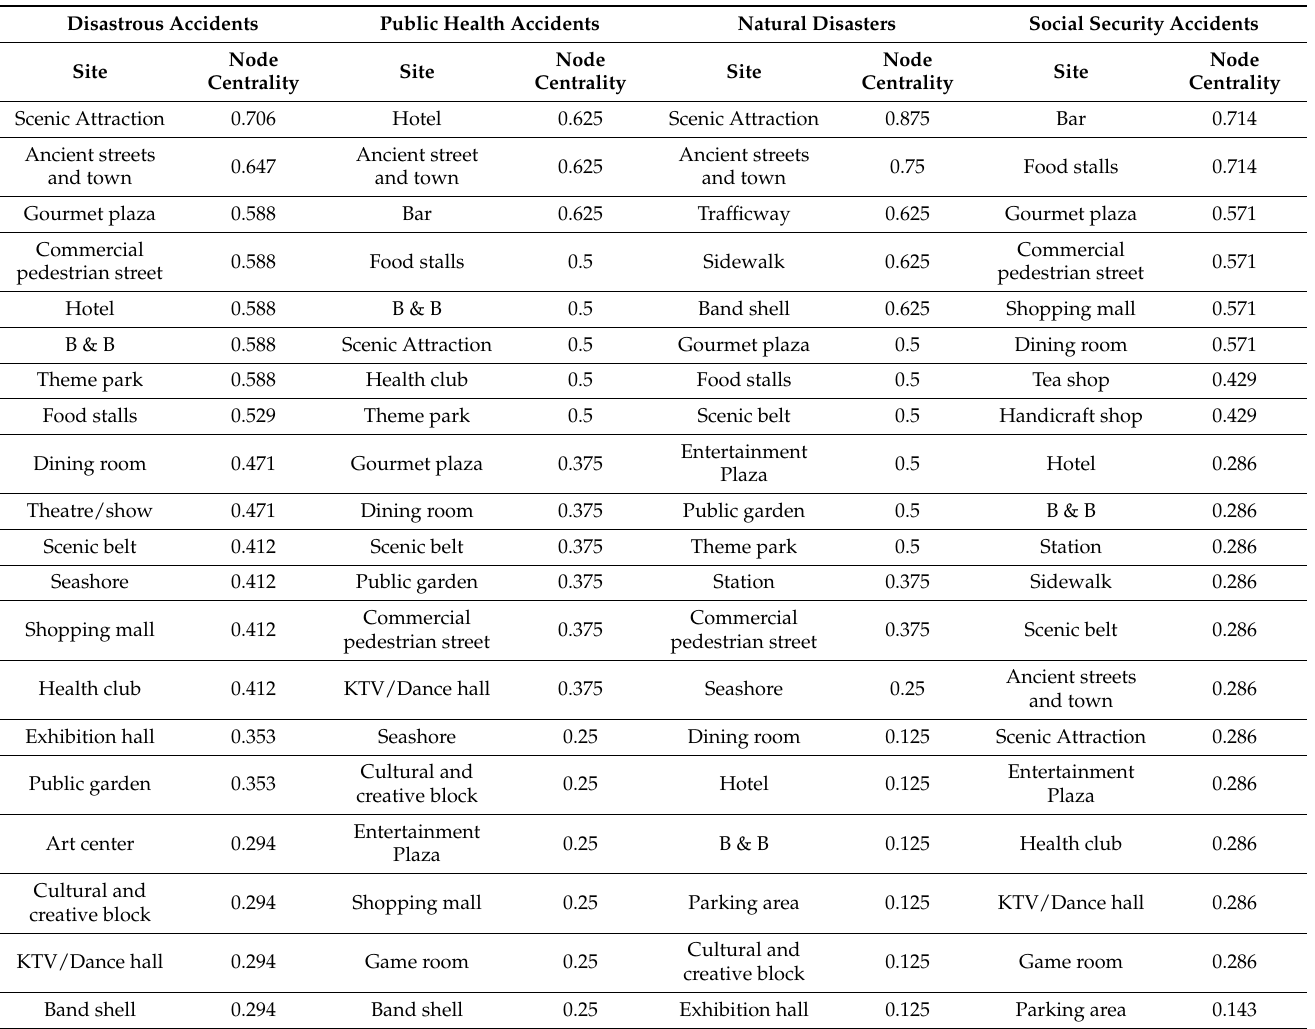
Table 4. Network centrality measurement of site-accident